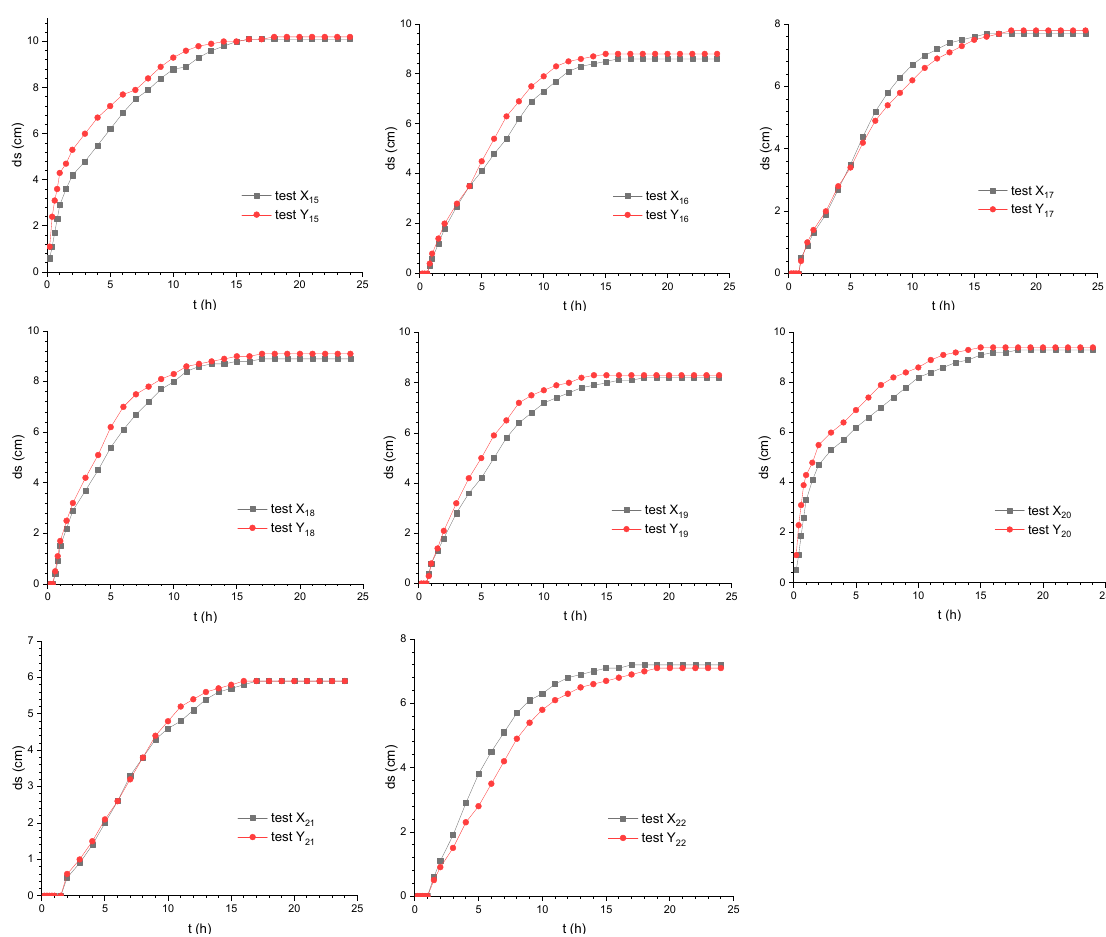
Figure 9. Comparison of the time variation of scour depths in corresponding tests of series X ( d 50 = 0.71 mm) and Y ( d 50 = 0.98 mm) with pier modifications ( X 11 –X 22 , Y 11 –Y 22 ; D p = 10 cm): tests X 11 and Y 11 ,……. tests X 22 and Y 22 .